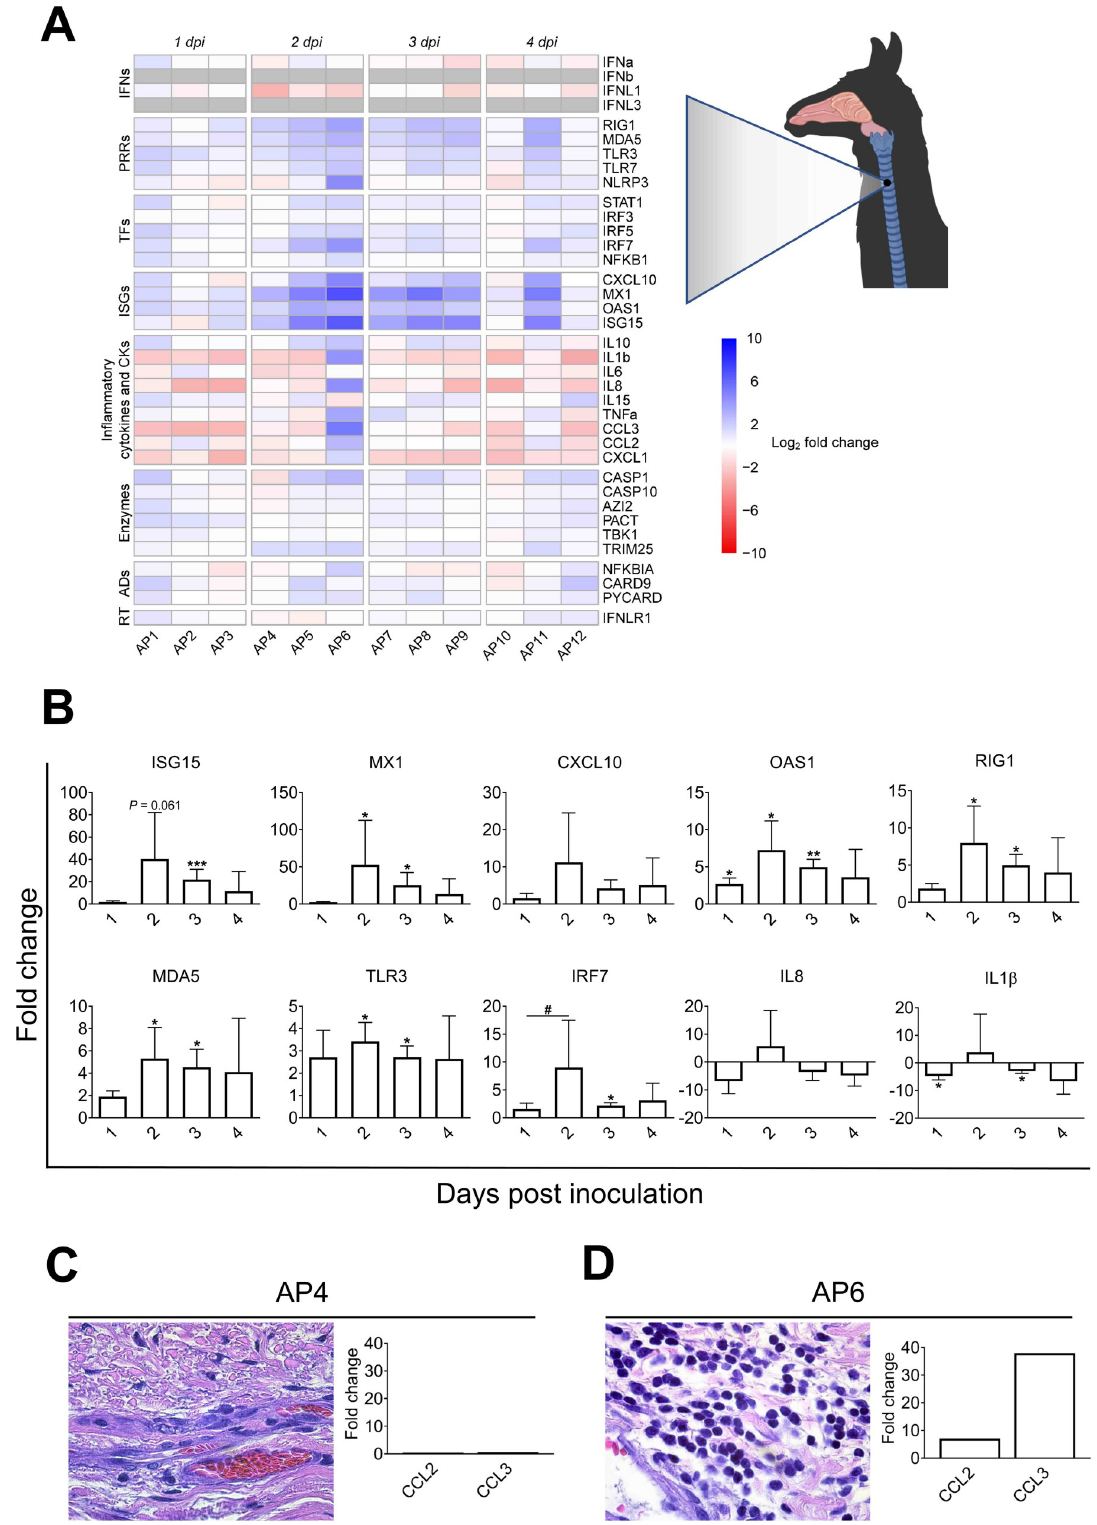
Fig 5. Kinetics of alpaca innate immune responses at the tracheal level in response to MERS-CoV Qatar15/2015. (A) Trachea samples were obtained by scraping MFPE sections from control (AP13-15) and infected alpacas (AP1-12), followed by RNA